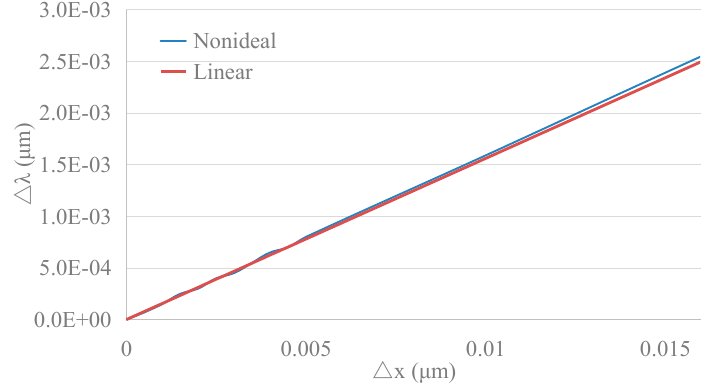
Figure 14. The output of the MOEMS gyroscope in linear and nonideal conditions.